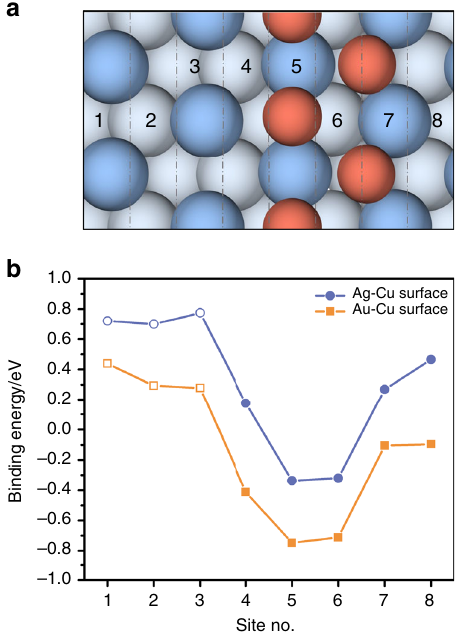
Fig. 1 Schematic diagram. The computational model is constructed by adding a single layer of Cu with a coverage of 1/2 ML (monolayer) on top of the three-layer Ag or Au substrate. The surface CO adsorption is under − 1.0 V SHE . The substrate orientation is chosen to be (111) because it is the most stable and abundant surface facet for bulk Ag or Au materials. A clean surface, CO 2( g ) , H 2 O ( l ) and H 2( g ) are used as references to construct the free energy surfaces. a Top view of the unit cell used for computational investigations (blue: top layer Ag or Au atoms; light blue: bottom layer Ag or Au atoms; orange: Cu atoms). The site numbers show the position and chemical environment of the binding sites. b Energy diagram for CO adsorption on the Ag-Cu surface (blue line) and Au-Cu surface (orange line). Data of sites nonadjacent to the surface Cu are shown in